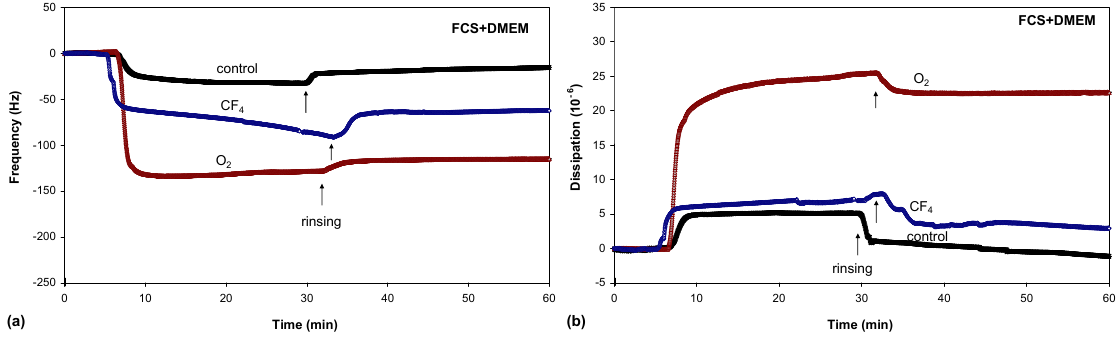
Figure 10. Frequency changes ( a ) and dissipation changes ( b ) for FCS/DMEM adsorption on untreated and plasma-treated PET